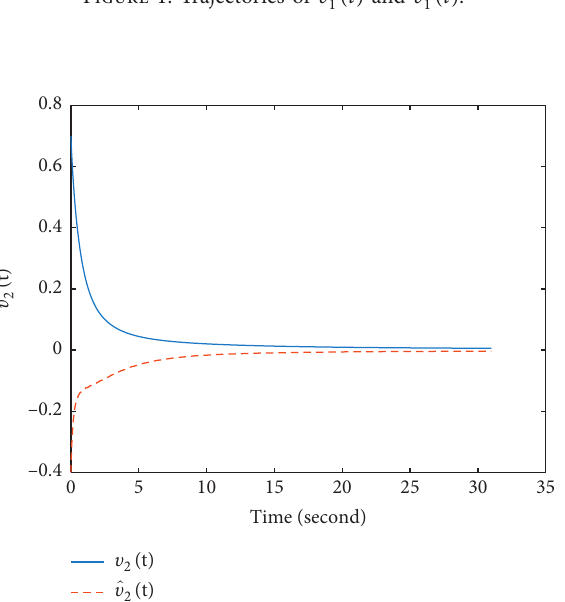
Figure 1: Trajectories of υ